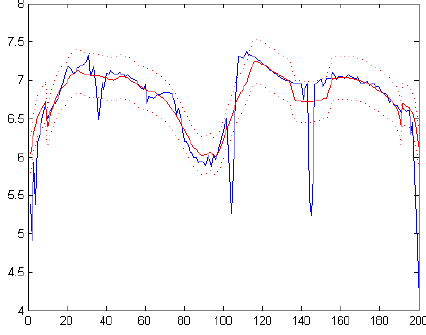
Figure 2. Exclusion of the unrelated spectral bands of the Indian pines dataset.